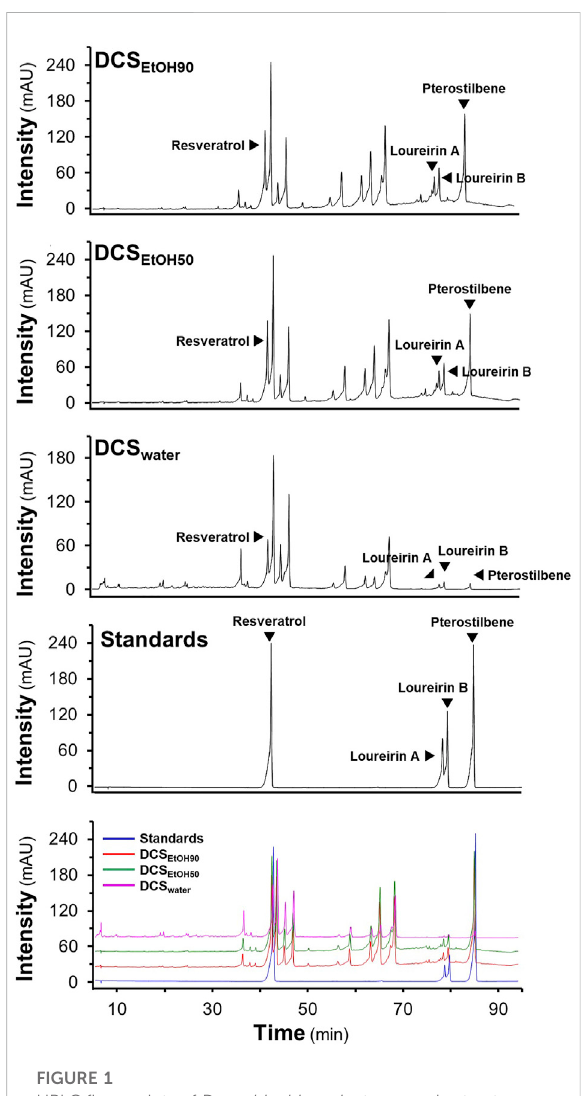
FIGURE 1 HPLC fi ngerprints of D. cochinchinensis stemwood